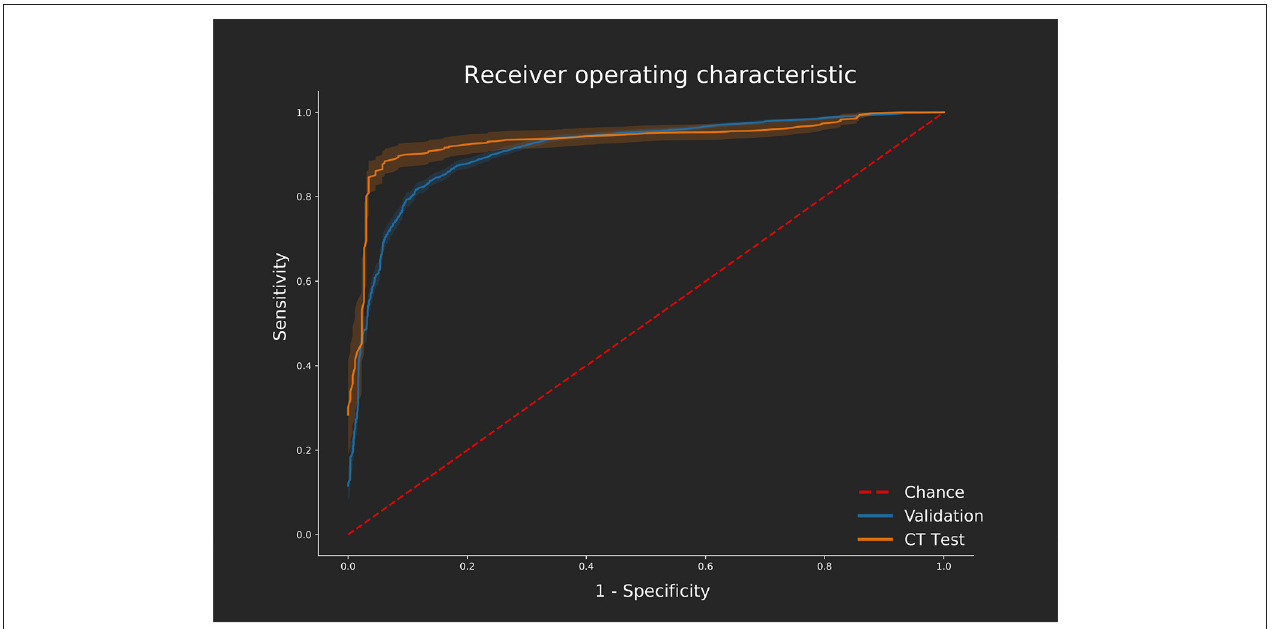
FIGURE 4 | ROC curves displaying the performance on the validation [magnetic resonance imaging (MRI) dataset] calculated across all 10 folds of cross validation using the optimum hyperparameter tuning. Performance of the independent computed tomography angiography (CTA) test set using the same network, trained with the MRI dataset only, is also shown. ROC curves were generated using the Scikit-learn ( 28) implementation varying the threshold required for a positive classification. Confidence is shown with 1 standard deviation from the mean sensitivity and specificity values shown for each curve as calculated using bootstrapping with